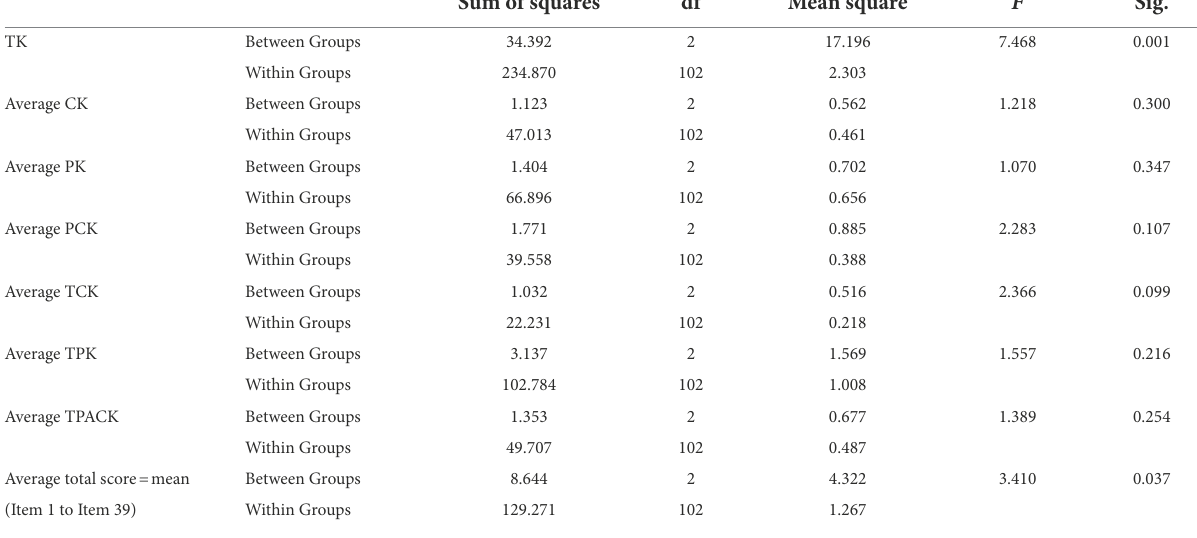
TABLE 6 ANOVA examining the differences among BA, MA and Ph.D. participants regarding TPACK. Sum of